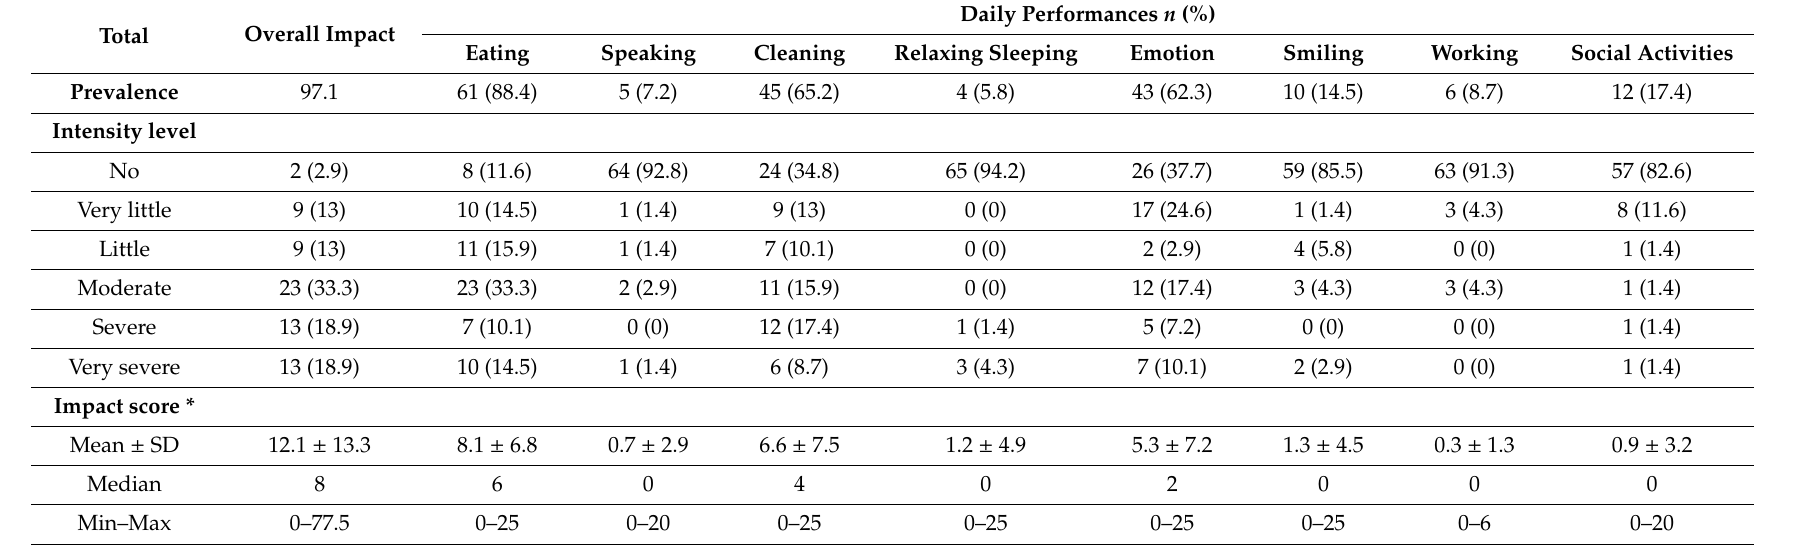
Table 1. Prevalence, intensity and impact score of the Oral Impacts on Daily Performance (OIDP) in OLP patients ( n = 69).